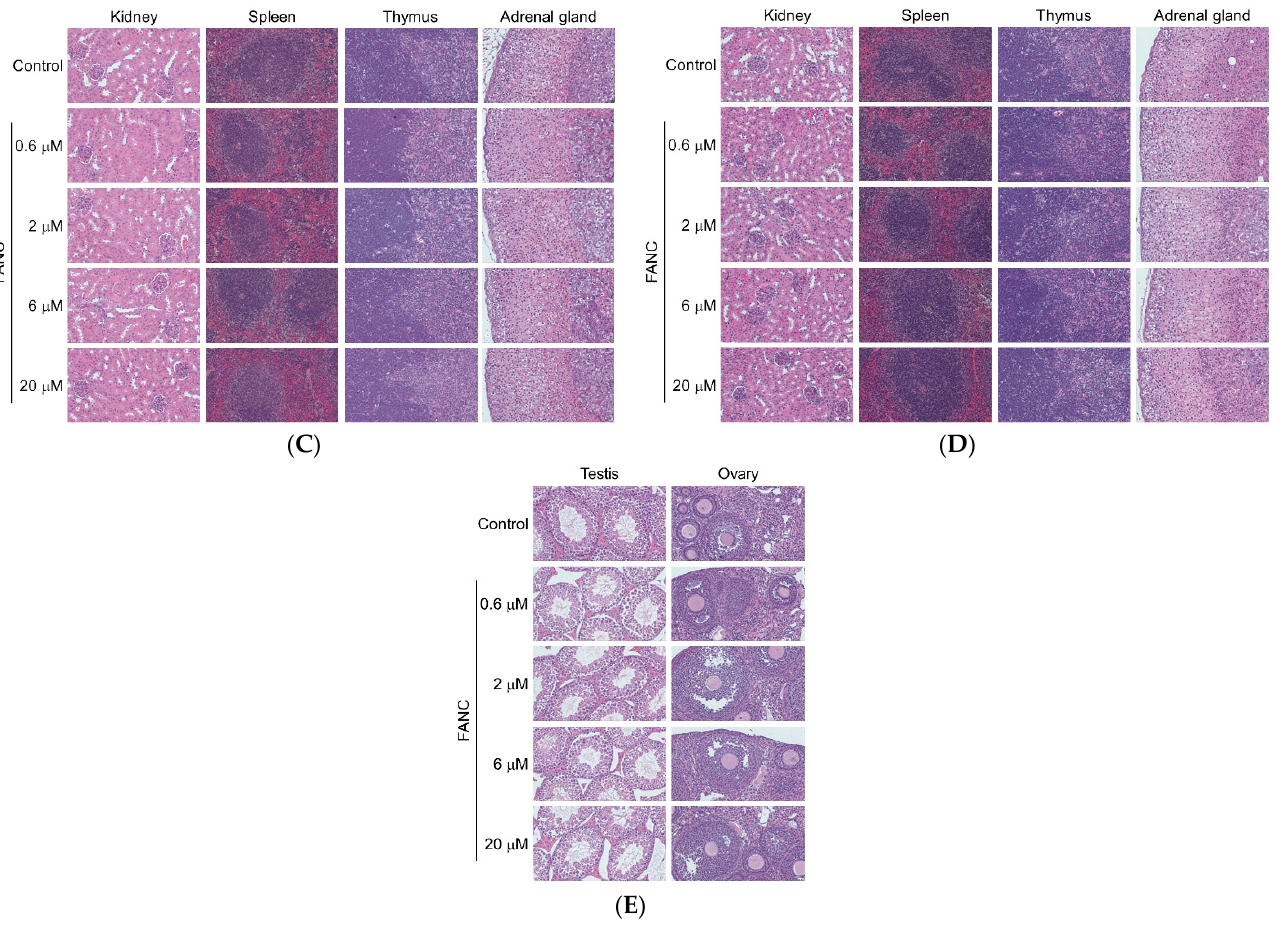
Figure 6. Representative H&E stained histology of tissue from ICR mice after feeding with FANC for 14 days. Section of brain, heart, liver, and lung from ( A ) male and ( B ) female mice. Section of kidney, spleen, thymus, and adrenal gland from ( C ) male and ( D ) female mice. ( E ) Section of testis and ovary from mice. Table 3. Changes of hematological parameters of ICR mice feeding with FANC for 14 days.